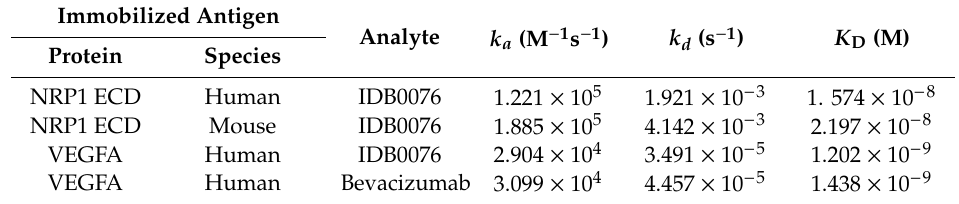
Table1. Bindinga ffi